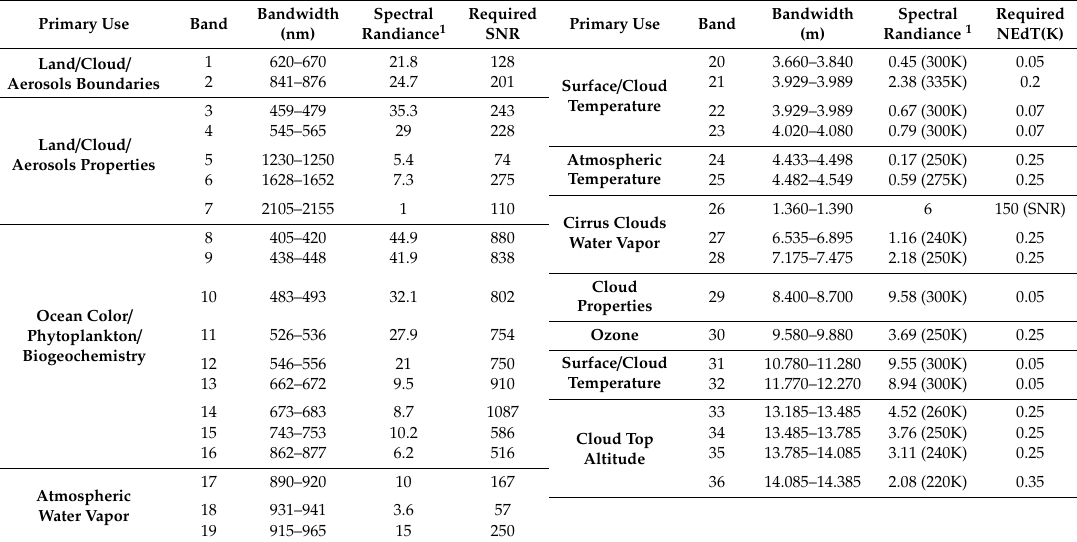
Table 1. Key design requirements of the moderate resolution imaging spectroradiometer (MODIS) spectral bands and primary applications. SNR: Signal-to-noise ratio; NEdT: Noise equivalent delta